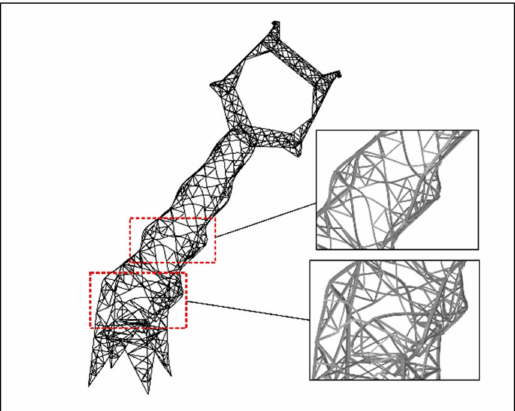
Figure 10. Stress–wind speed variation curve of buckling member.